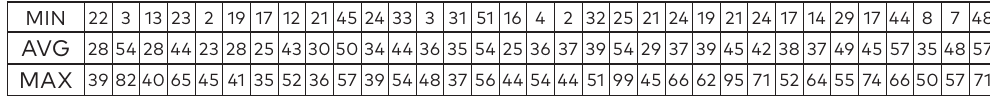
Table 7. Table 7. Measured E (lux) value distribution min, average and max values from 717 measurement comparison per street